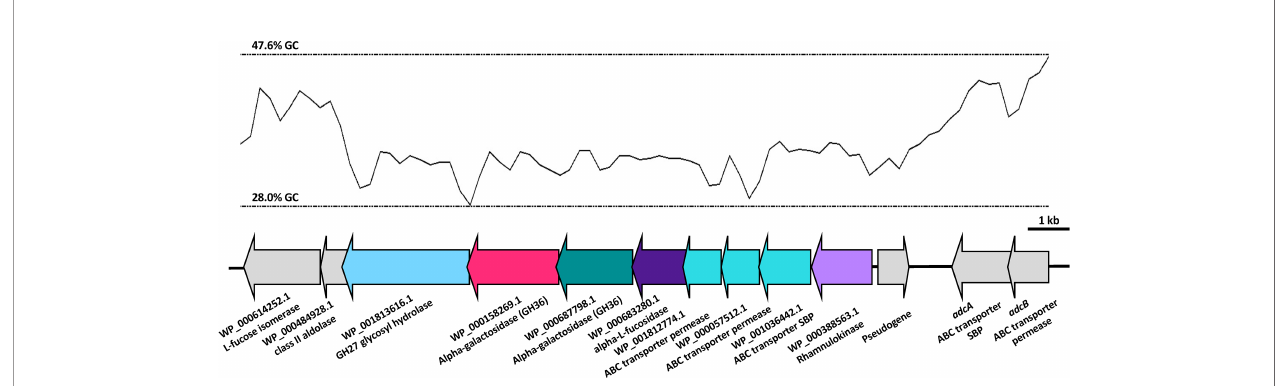
FIGURE 10 | Organisation of the S. pneumoniae 4559 alpha-galactosidase region. The GC content of the DNA is shown as a black line, with the upper and lower limits for this region as dotted lines. Open reading frames of genes are depicted in the direction of transcription, with genes in the lower GC region shown as colored arrows and genes adjacent to this region as grey arrows. The protein identi fi cation (ID) or name (if known), and putative function are indicated below the genes. Genes have been drawn